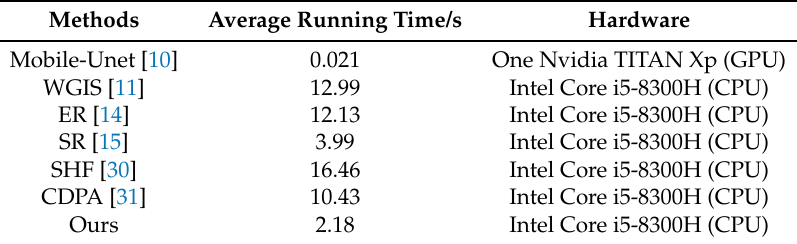
Table 4. Comparison of running time by seven different